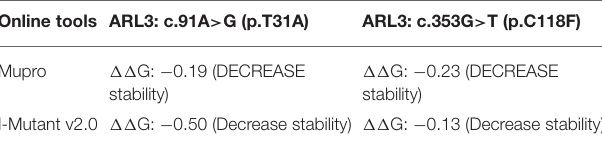
TABLE 2 | Prediction of the protein stability with online tools. Online tools ARL3: c.91A > G (p.T31A) ARL3: c.353G > T (p.C118F)